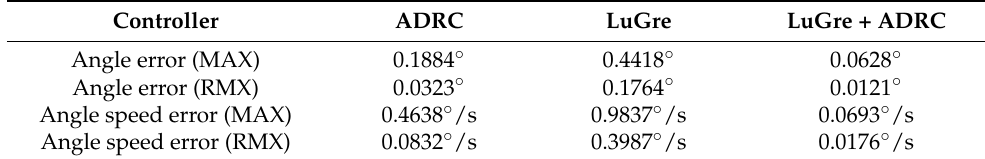
Table 2. Comparison of angle tracking error and angle speed error under sinusoidal input